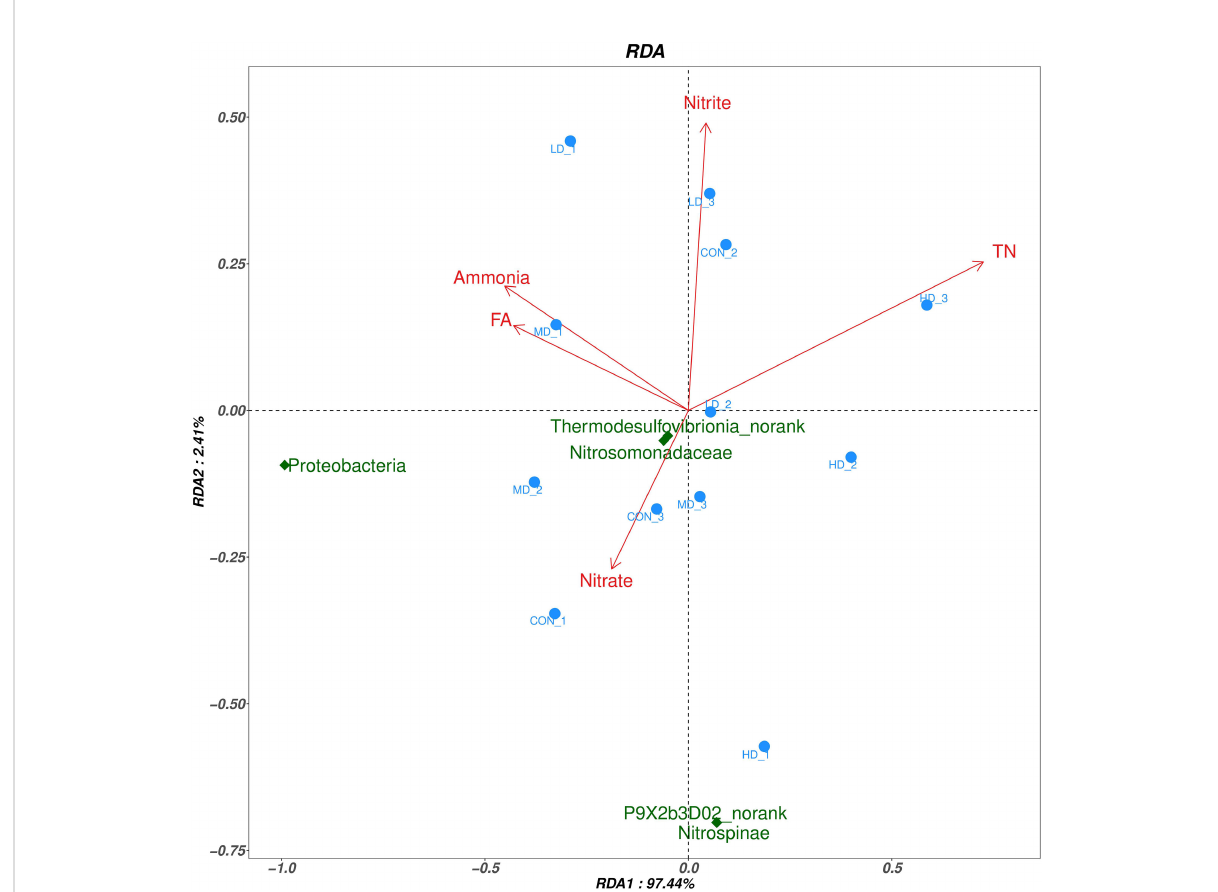
FIGURE 8 Redundancy analysis (RDA) to reveal the correlations between environmental factors and the differential bacterial taxa.